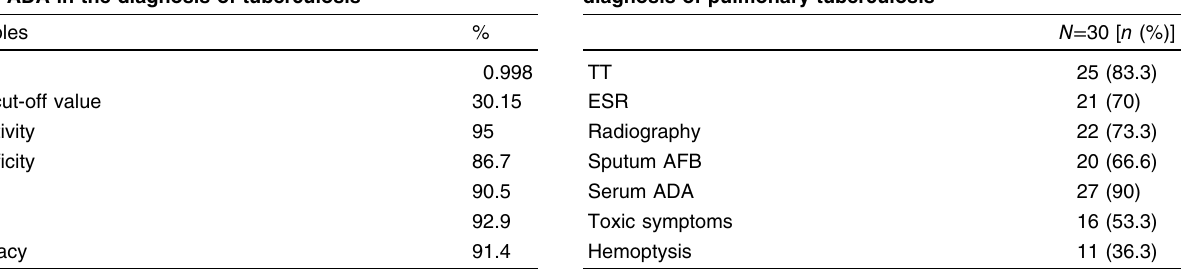
The percentage positivity of different parameters in the diagnosis of pulmonary TB. Serum ADA shows high percentage positivity (90%), followed by tuberculin skin test (83.3%), chest radiography (73.3%), ESR (70%), sputum AFB (66.6%), toxic symptoms (53.3%), and hemoptysis 36.3%. ADA, adenosine deaminase; AFB, acid-fast bacilli; ESR, erythrocyte sedimentation rate; TT, tuberculin